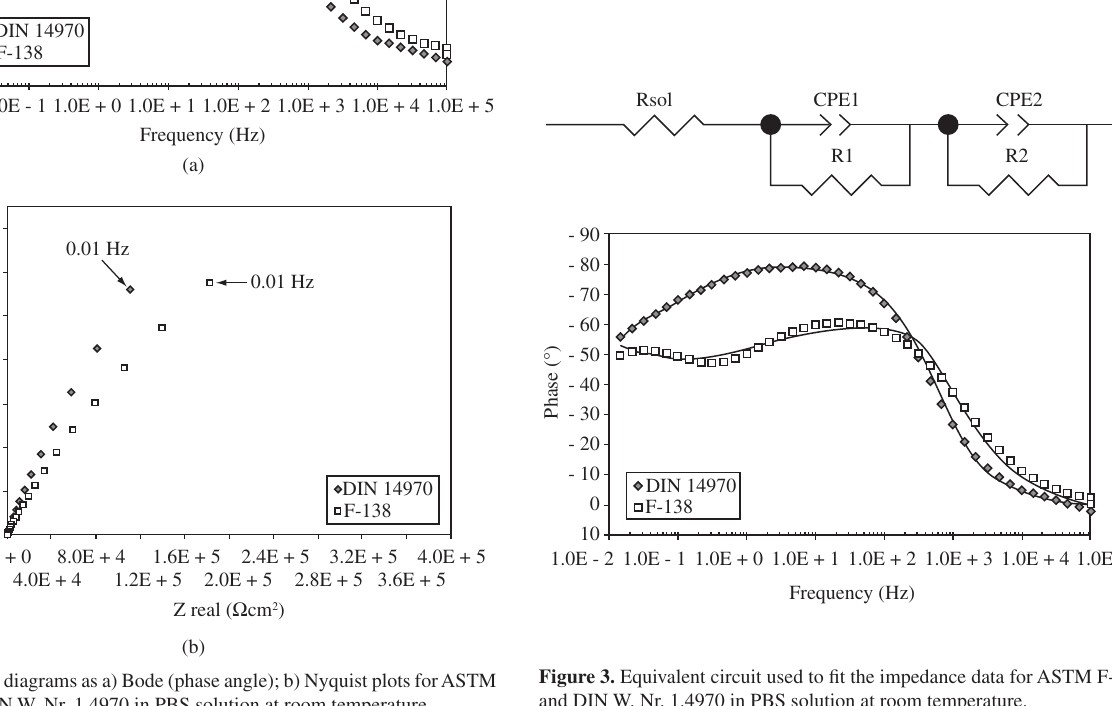
Figure 2. EIS diagrams as a) Bode (phase angle); b) Nyquist plots for ASTM F-138 and DIN W. Nr. 1.4970 in PBS solution at room temperature.